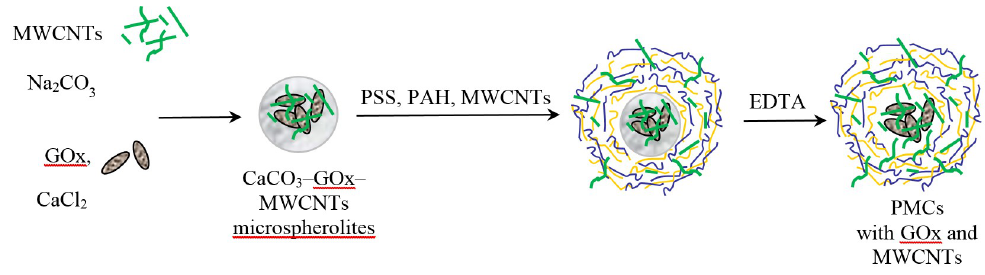
Figure 1. Formation of polyelectrolyte microcapsules with the enzyme and nanotubes.